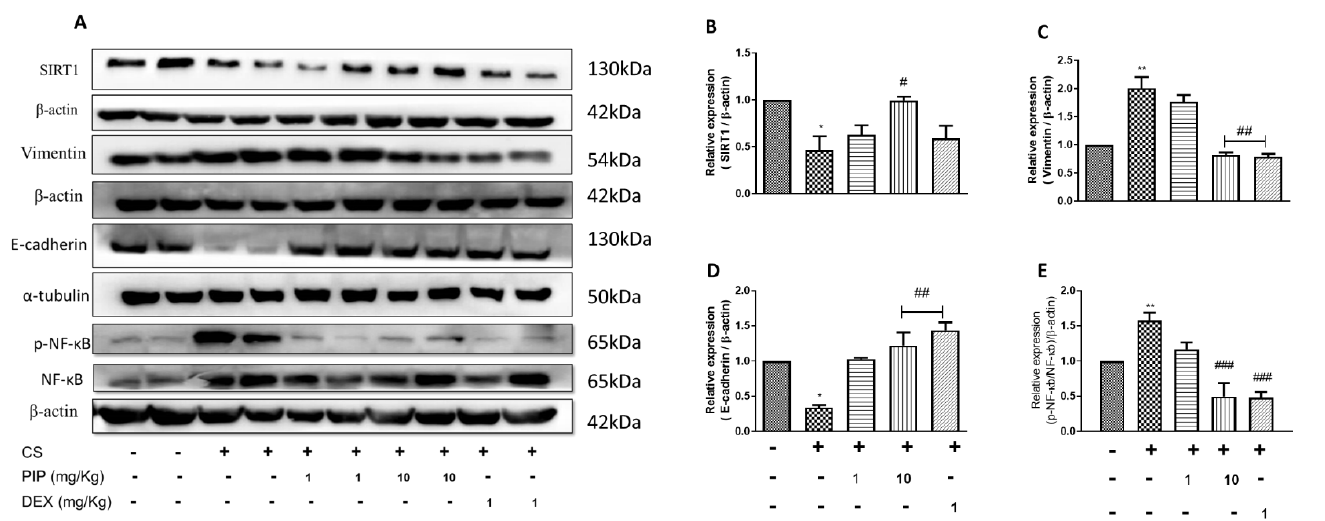
Figure 9. Effect of piperine treatment on expression of EMT changes, antioxidant, and SIRT1 signaling in CS-exposed murine model: ( A ) Immunoblot images representing the expressions of SIRT1, E- cadherin, N-cadherin, Vimentin, and p-NF- κ B/NF- κ B. Bar graphs representing densitometry analysis of ( B ) SIRT1 ( C ) vimentin, ( D ) E-cadherin and ( E ) p-NF- κ B/NF- κ B. The values are expressed as mean ± SEM ( n = 3). * p < 0.05 and ** p < 0.01 vs. Unexposed, # p < 0.05, ## p < 0.01 and ### p < 0.001 vs. CS. CS: cigarette smoke exposure, CS + PIP (1): cigarette smoke exposure + 1 mg/kg PIP, CS +